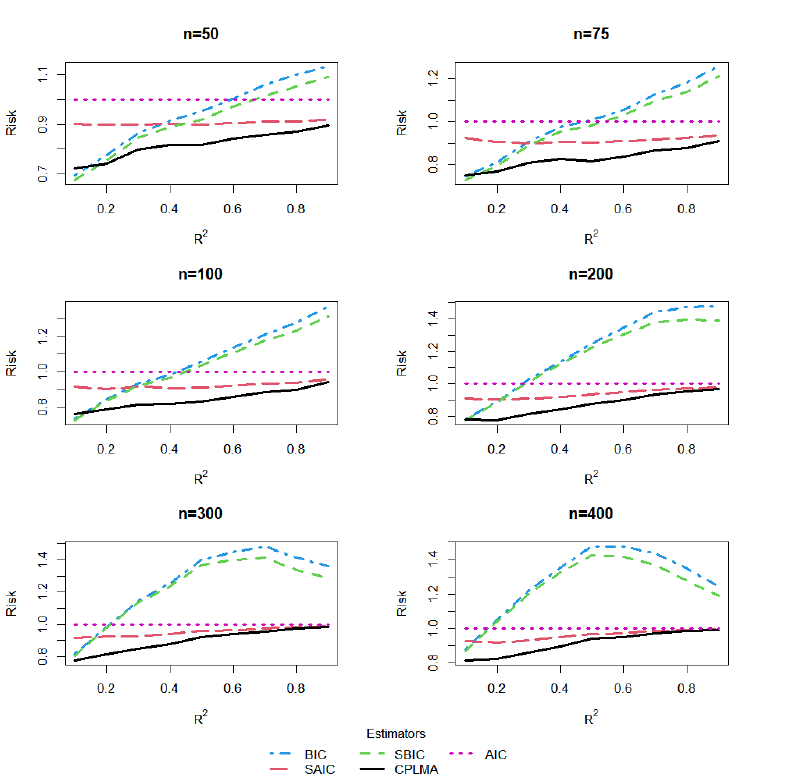
Figure 9. Risk comparisons for Design 2 when α = 0.5 and the censoring rate is about